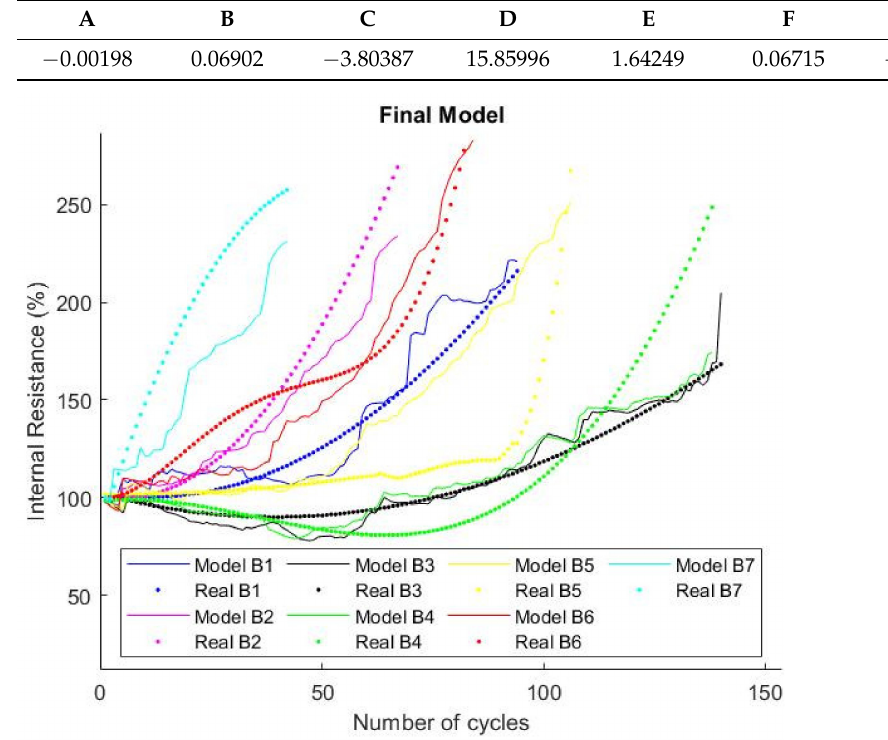
Figure 25. Results of final model including batteries